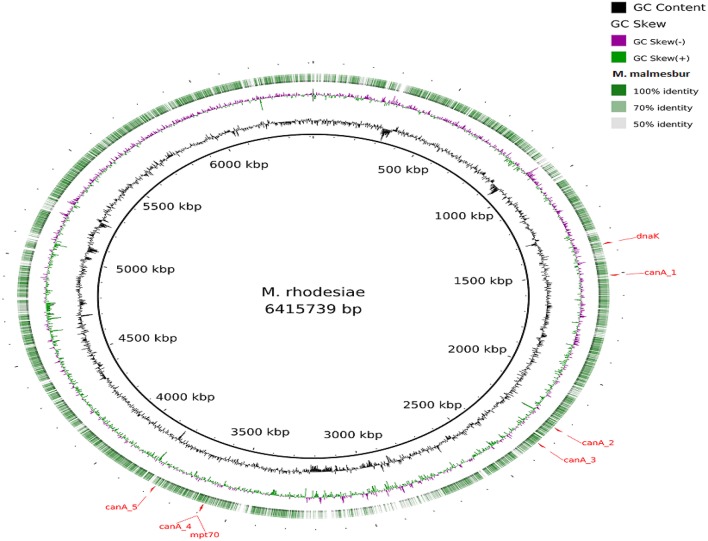
Alignment of M. malmesburii sp. nov. predicted CDS regions to those of M. rhodesiae NBB3 (CP003169.1) using BRIG. Immunogenic proteins of interest identified in M. rhodesiae are highlighted in red (dnaK: locus tagMycrhN_1341, product chaperone protein DnaK; mpt70: locus tag MycrhN_3596, product secreted/surface protein with fasciclin-like repeats; canA_1: locus tag MycrhN_1479, product sulfate permease-like transporter, MFS superfamily; canA_2: locus tag MycrhN_2217, product carbonic anhydrase; canA_3: locus tagMycrhN_2307, product isoleucine patch superfamily enzyme, carbonic anhydrase/acetyltransferase; canA_4: locus tag MycrhN_3599, product isoleucine patch superfamily enzyme, carbonic anhydrase/acetyltransferase; canA_5: locus tag MycrhN_3776, product carbonic anhydrase. Carbonic anhydrase genes have been numbered according to genomic position).